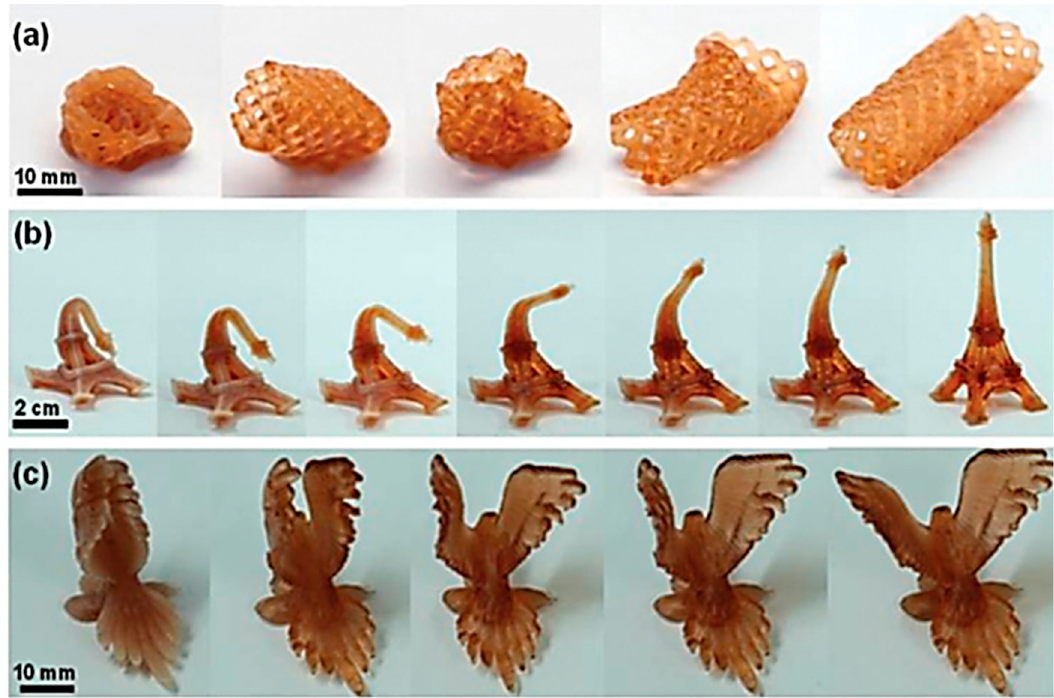
Figure 11. 4D shape-changing structures printed using stereolithography with a molten macromethacrylate can impart shape memory to nearly any object: ( a ) A model cardiovascular stent with a length of 3 cm, strut thicknesses of 600 μ m and open cells of 2.5 mm × 2.5 mm, reverting to its original shape at 70 °C. Printing such a model stent takes 1 h with the Asiga printer; ( b ) an Eiffel Tower model, 6 cm tall, reverting to its original shape at 70 °C; and ( c ) a bird with a 3-cm wing span reverting to its original shape at 70 °C [112]. Reproduced with permission from Wiley.